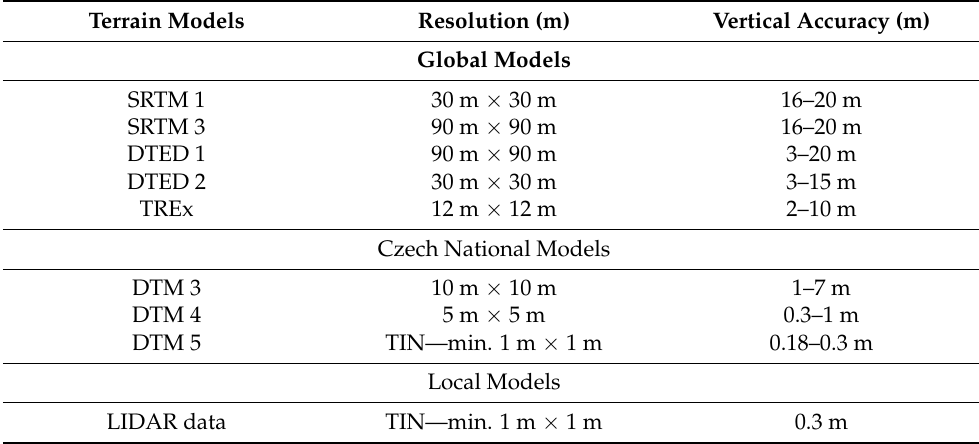
Table 1. An overview of global elevation data and data from the territory of the Czech Republic and their altitude accuracy [4]. Unlike the rest of the models, DTM 5 is formed by an irregular grid of points